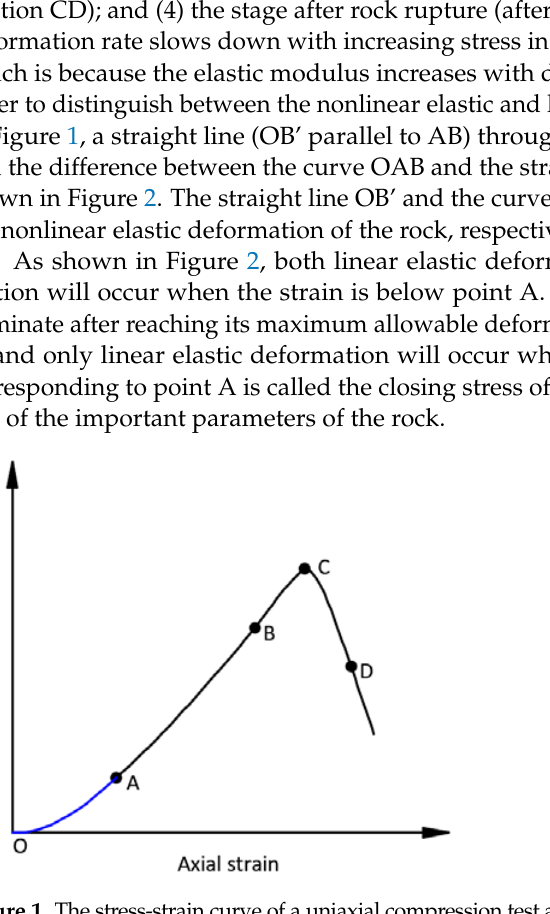
Figure 1. The stress-strain curve of a uniaxial compression test adapted from Corkum. Adapted from